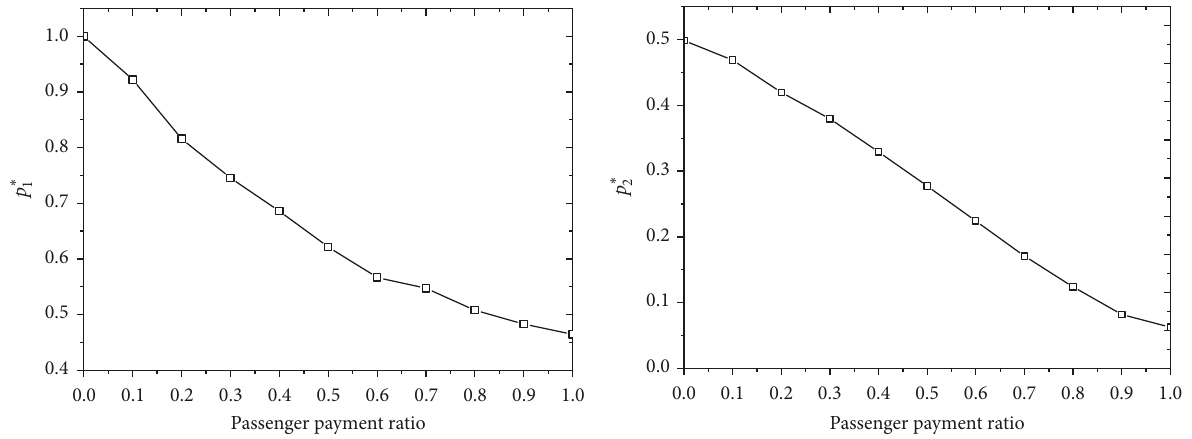
Figure 5: Influence of payment ratio on threshold.